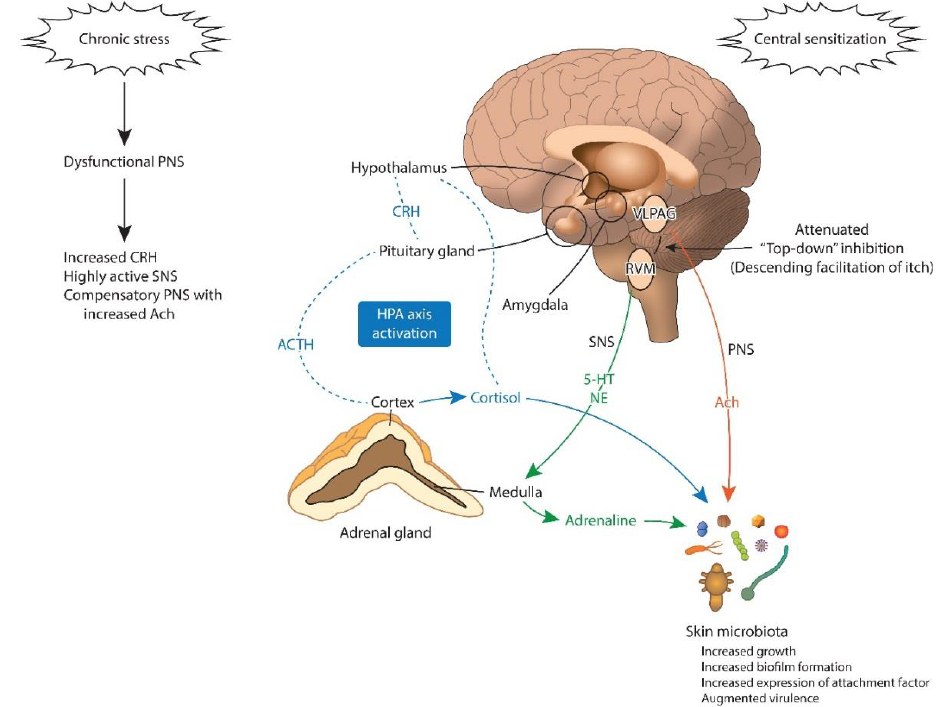
Figure 3. Brain to microbiota communication under chronic stress. The HPA axis is activated under chronic stress. The final product of the HPA axis, cortisol, directly activates skin microbes. Cortisol